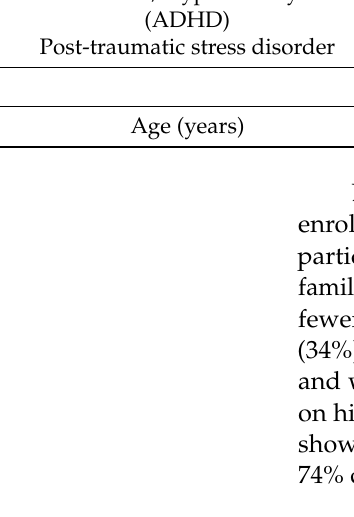
Table 2. Characteristics of 350 pediatric and 196 adult patients with Down syndrome (DS) in the Massachusetts General Hospital Down Syndrome Program (MGH